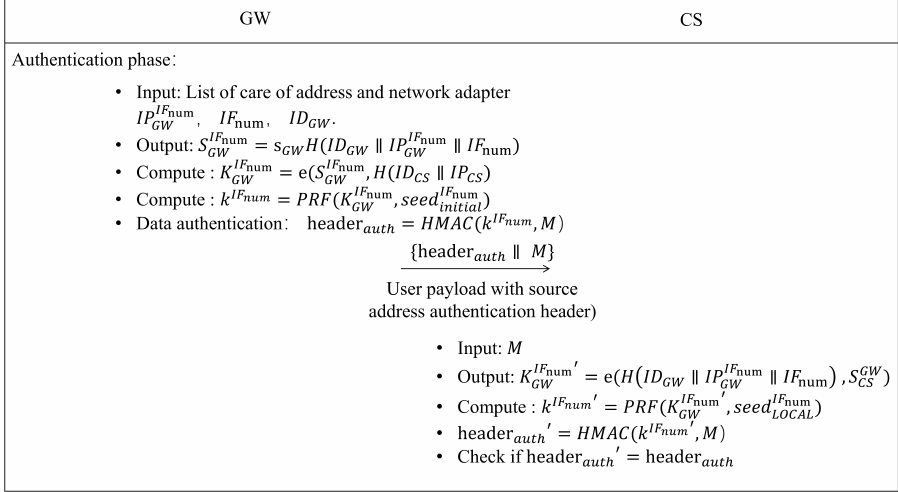
Figure 7. Authentication and data transmission